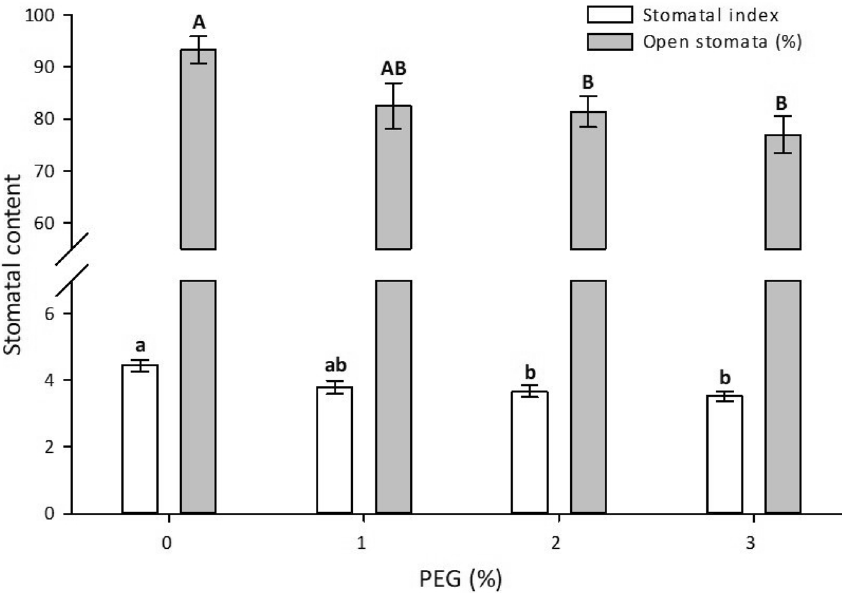
Figure 3. Effect of PEG 6000 on the stomatal content of in vitro Vanilla planifolia shoots at 60 days of culture. Values represent the mean ± SE (standard error). Means with different letters are significantly different (Tukey, p ≤